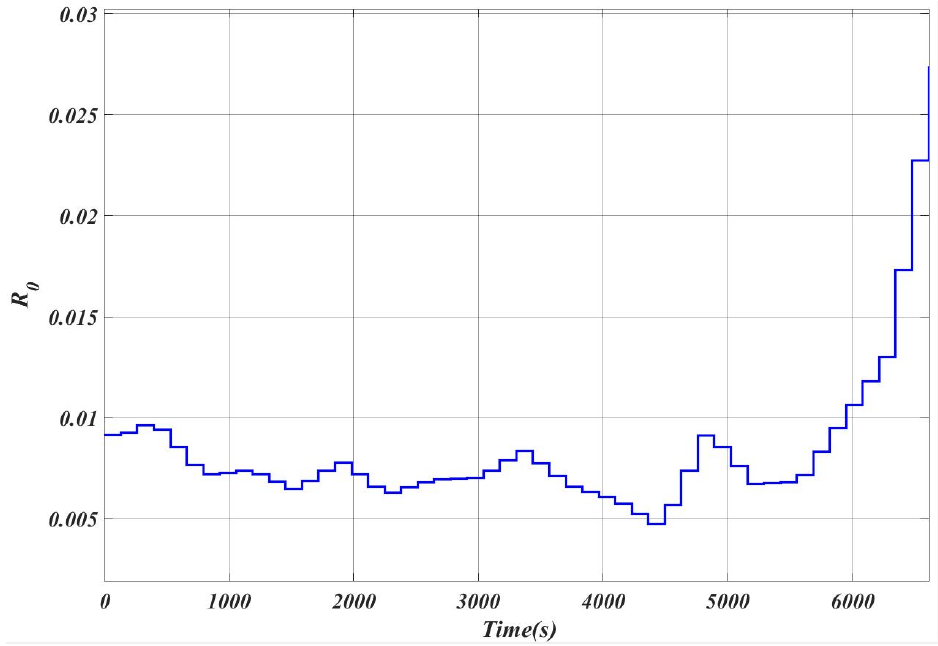
Figure 14. R 0 vs. Time.